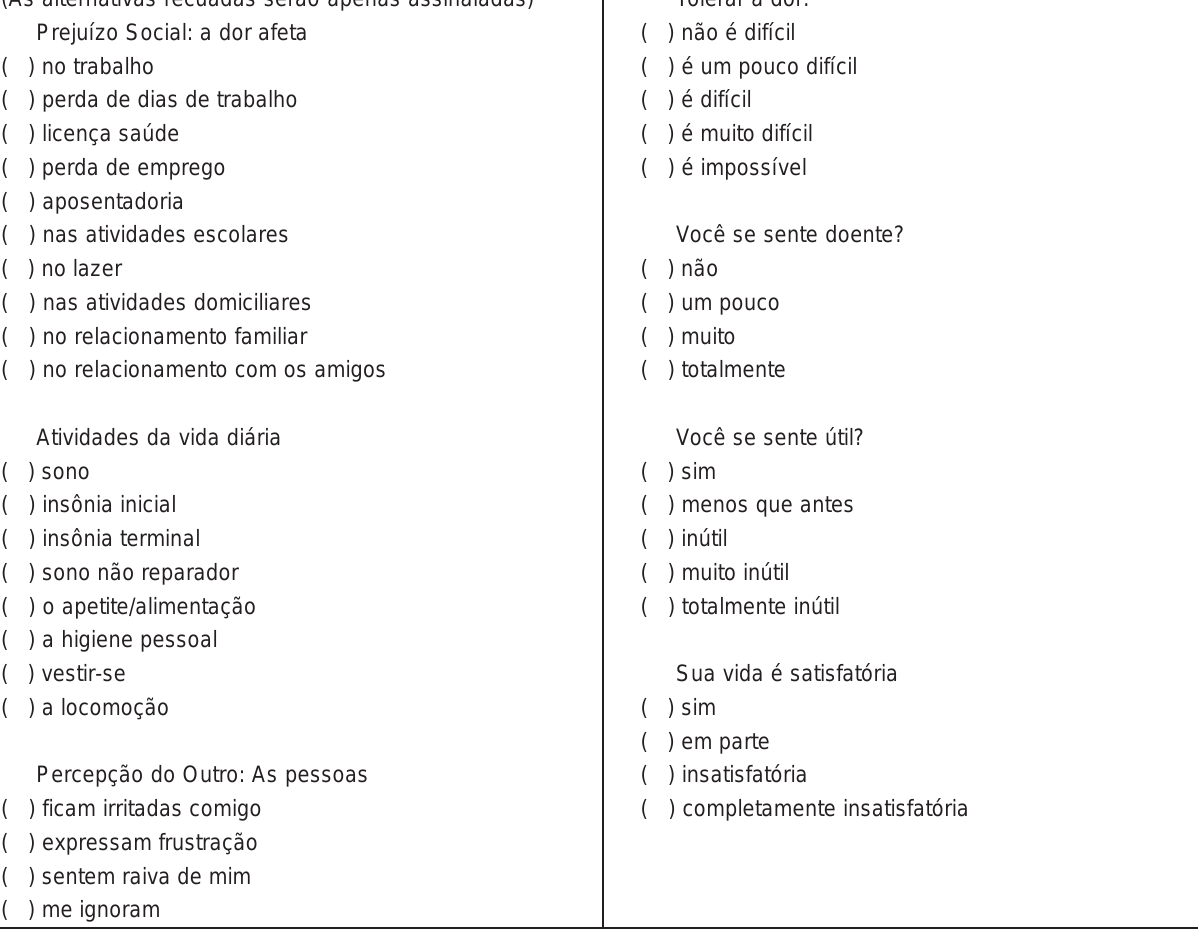
FIGURA 1- Questões sobre o impacto da dor na vida do paciente. Parte integrante da versão brasileira do questionário McGill de dor, proposta por Castro